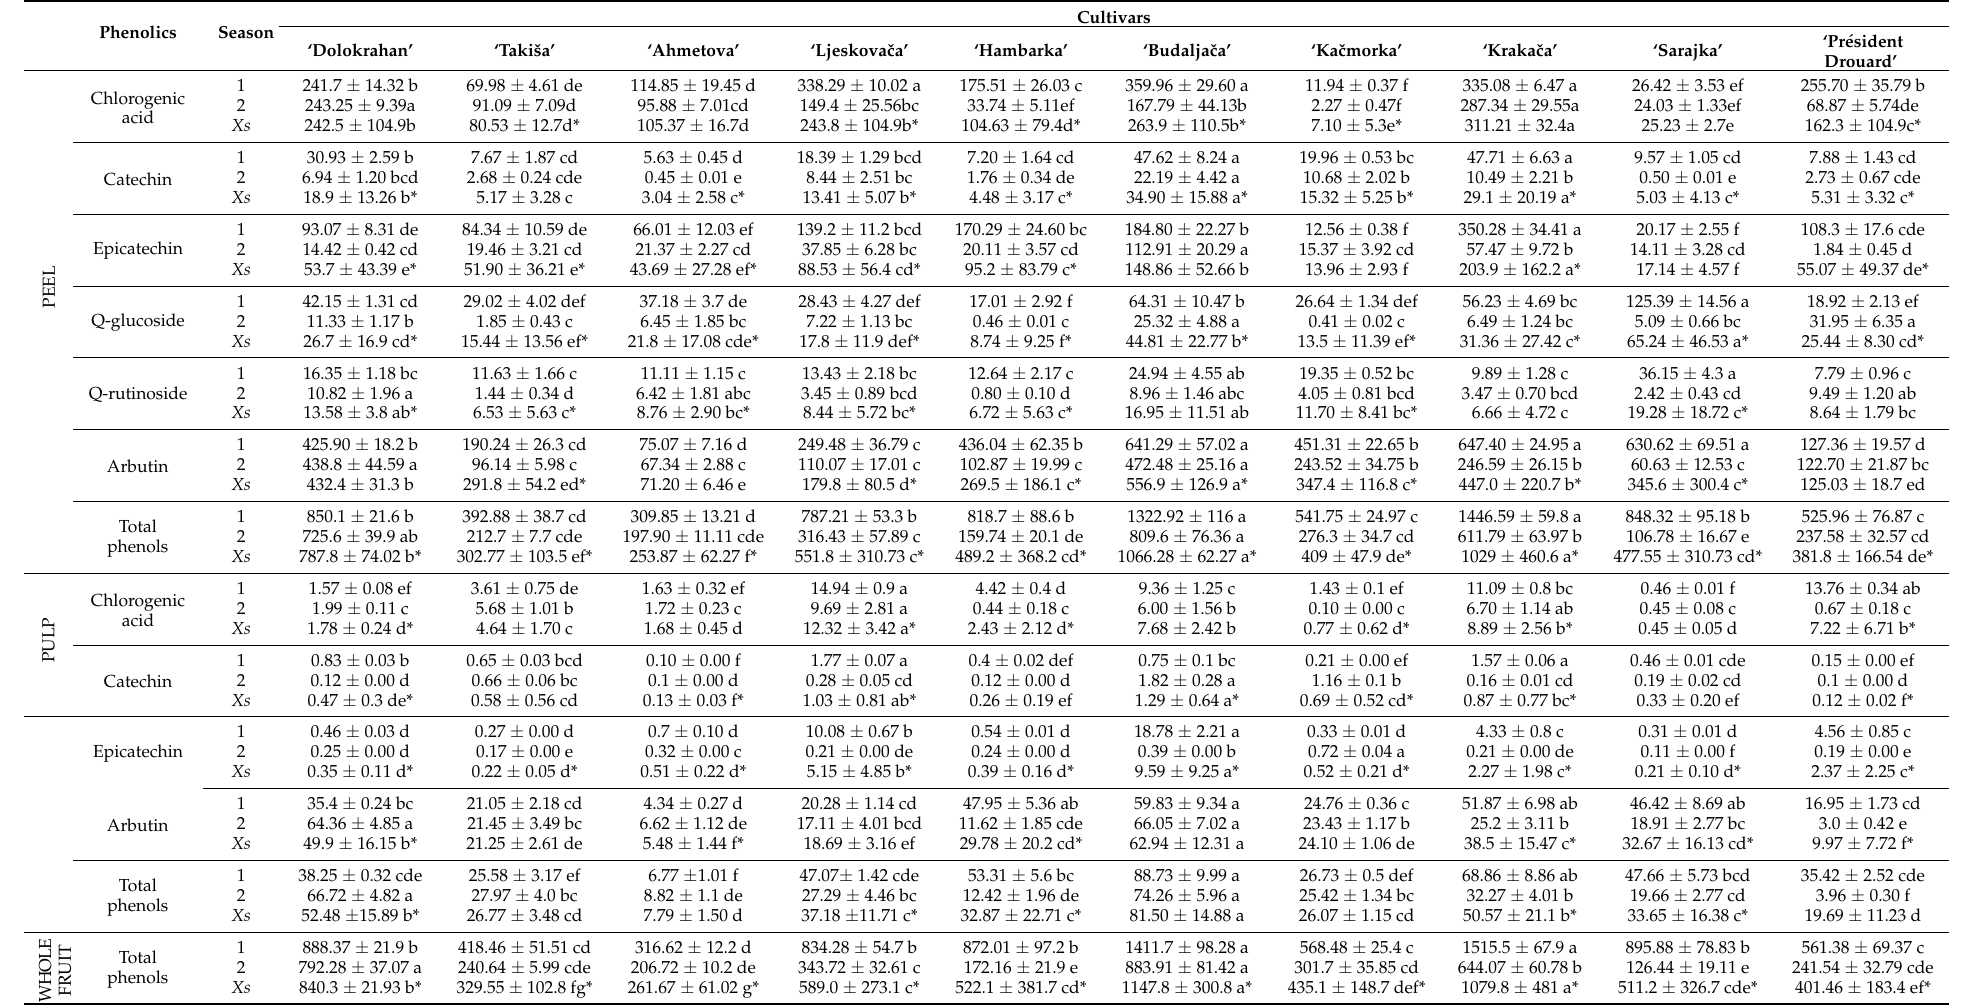
Table 4. Content of phenolic compounds and total phenols (mg kg − 1 ) in different parts of pear fruit cultivars during two growing